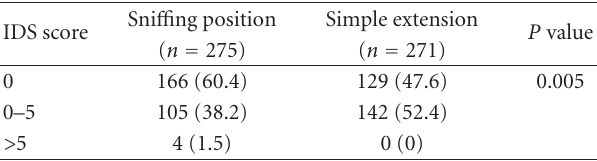
Table 4: Intubation Di ffi culty Scale (IDS) score.